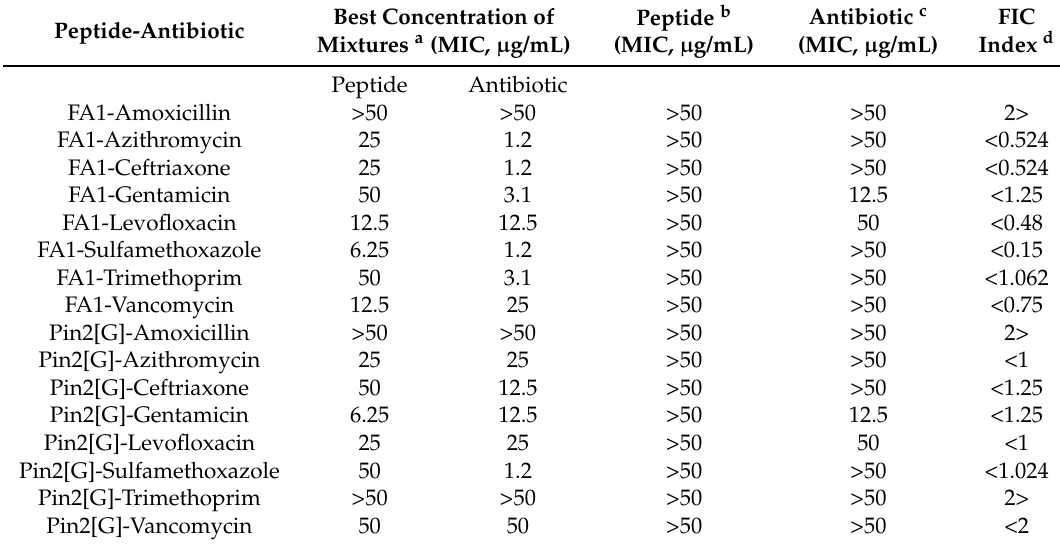
Table 3. Best concentration mixtures of peptides and commercial antibiotics tested to inhibit the growth of Klebsiella pneumoniae